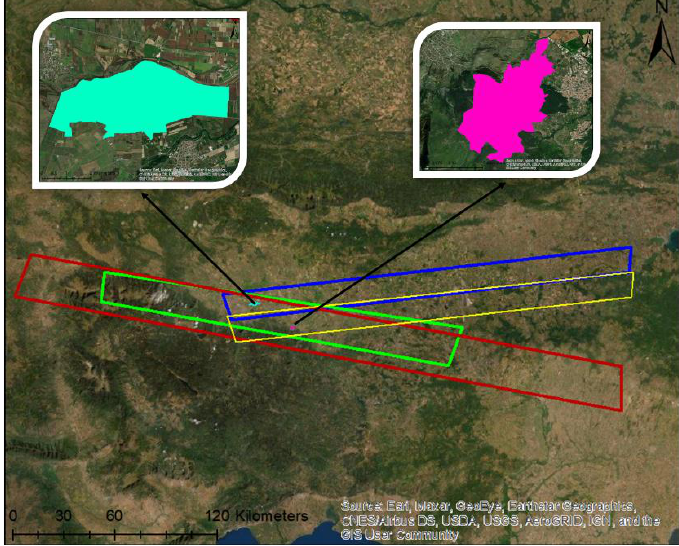
Figure 2. Footprints of selected Corona (blue and yellow) and Hexagon images (red and green) on Google Earth image. The areas shaded by cyan and pink show Stamboliyski and Ruen, respectively.